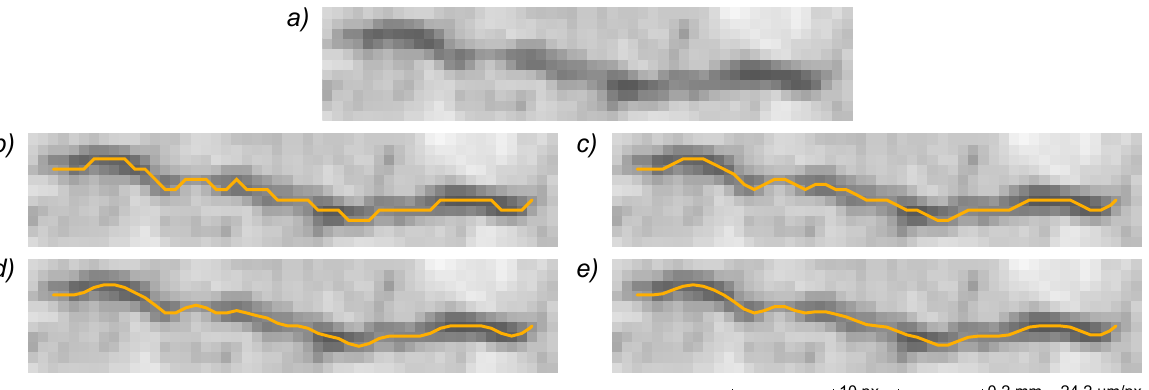
Figure 11. EG smoothing. A crack EG ( b ) is obtained from the original image ( a ) with vertices corresponding to pixel centers, resulting in a quite rough path. Paths deriving from one ( c ), two ( d ) and three ( e ) EG smoothing iterations, respectively, demonstrate a progressive improvement in evenness.